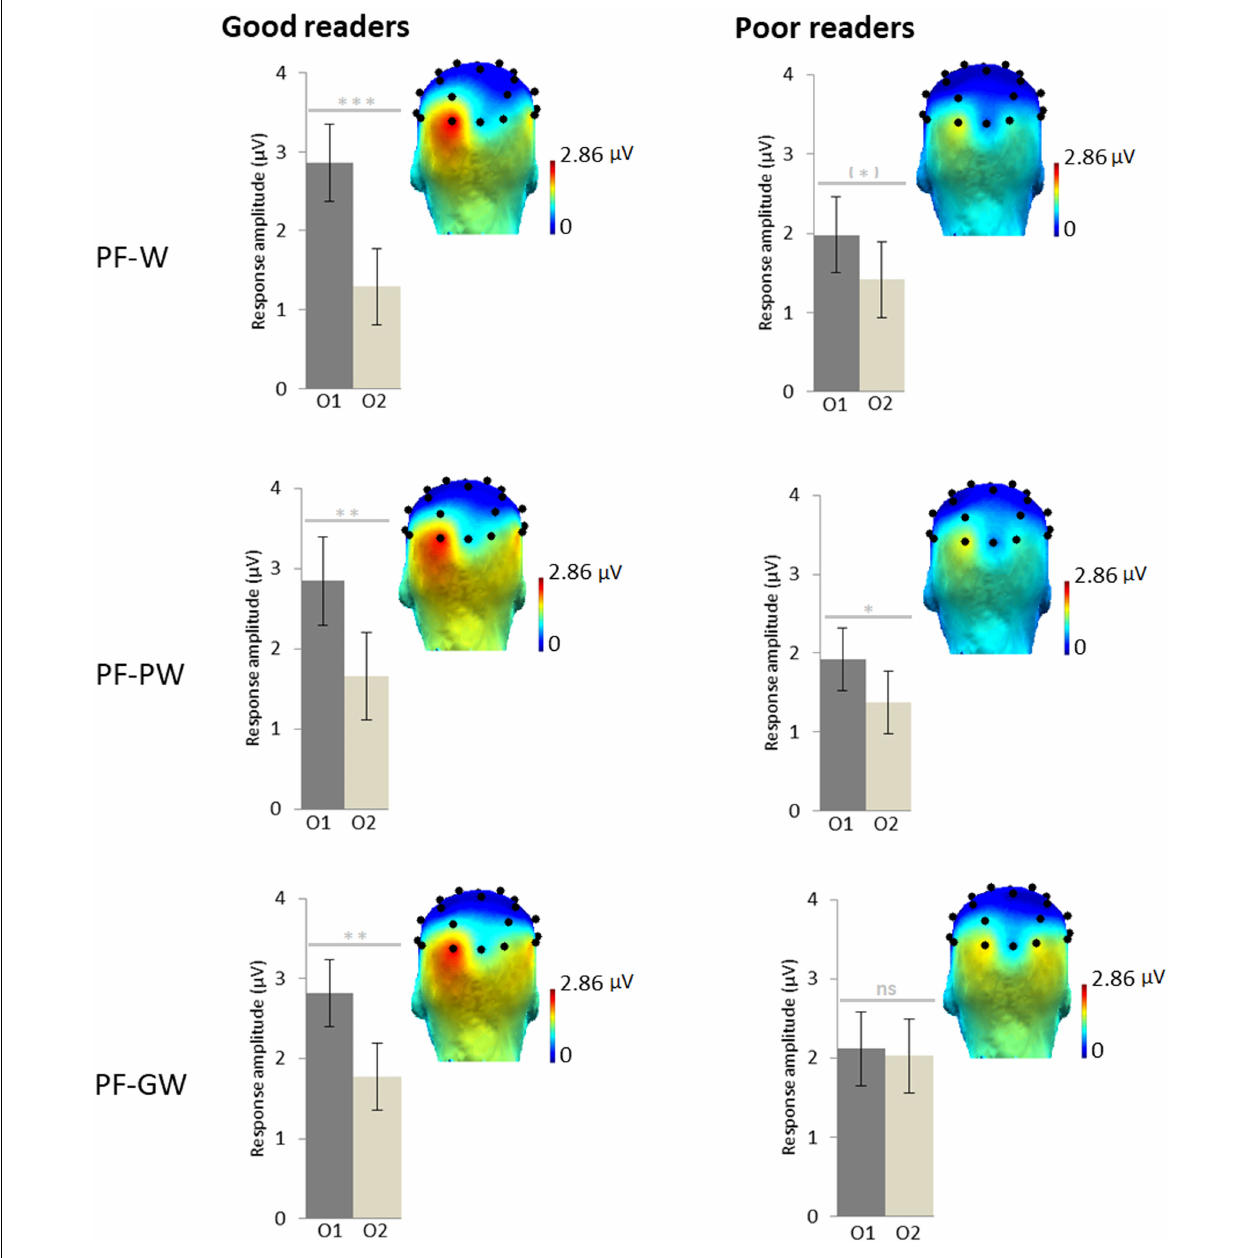
FIGURE 3 | Response amplitudes and topographies by reading level. Scalp topographies for the response in each condition at the target frequency (sum of baseline subtracted amplitudes at significant harmonics: 1.2, 2.4, 3.6, and 4.8 Hz; see section “Materials and Methods”) for children assigned in the good readers group ( N = 18) and in the poor readers group ( N = 19) on the basis of their behavioral reading scores. Histograms represent the same data, with standard errors of the mean. Stars indicate significant difference between the left (O1) and the right (O2) occipital electrodes ( ∗ p < 0.05; ∗∗ p < 0.01; ∗∗∗ p < 0.001, ns: not significant). Individual EEG data summarized in Figure 3 are provided in Supplementary Data Sheets S2–S4 , and described in Supplementary Data Sheet S1